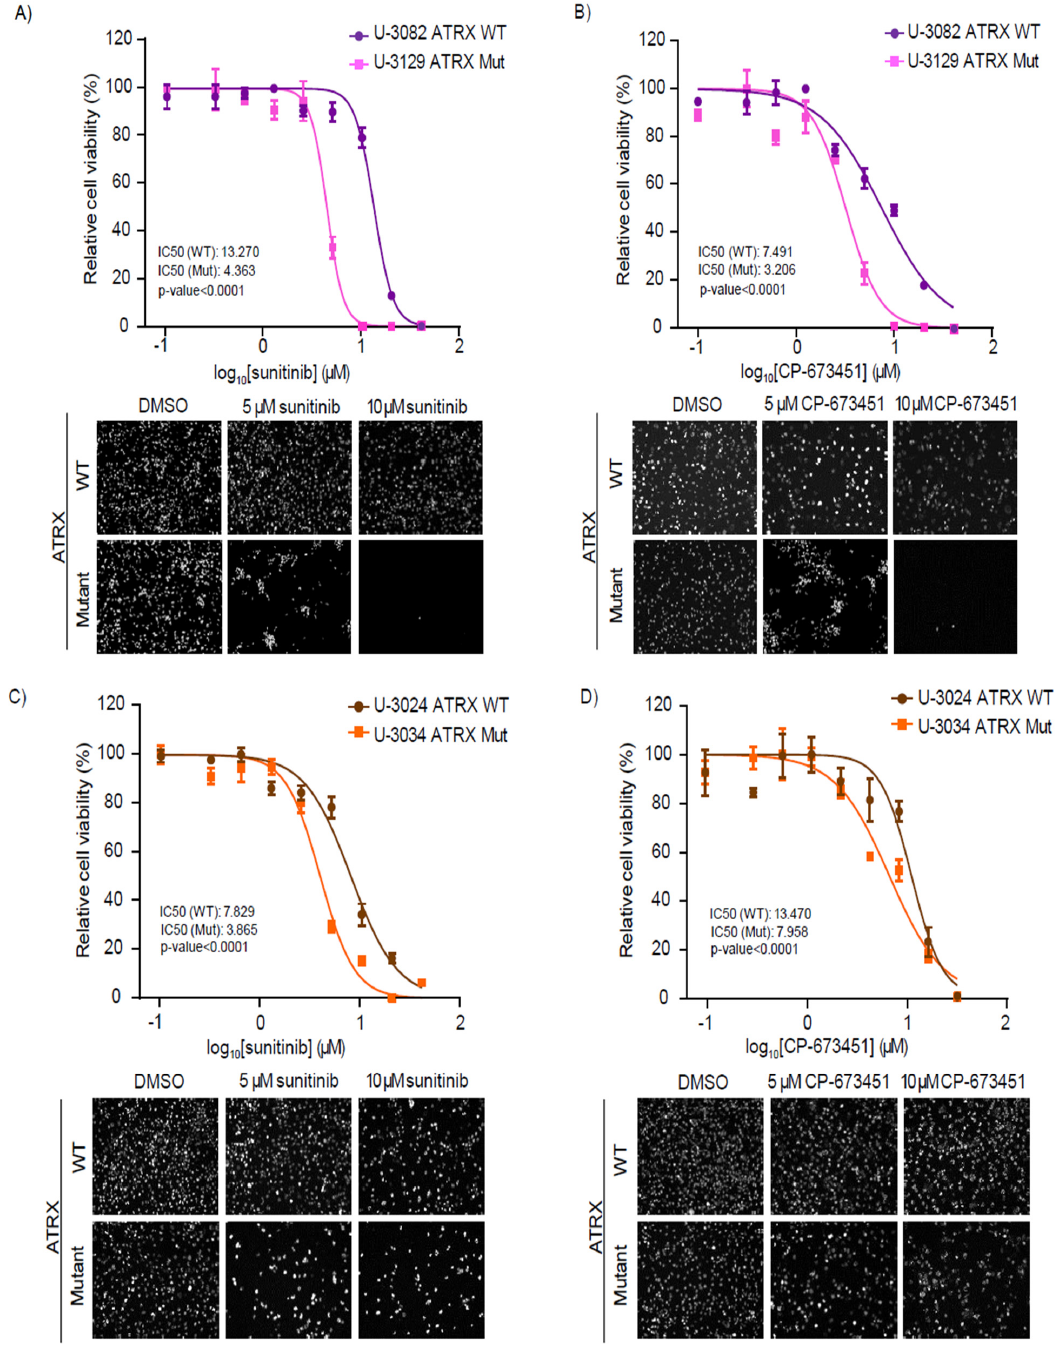
Figure 5. ATRX -mutant patient-derived high-grade glioma cells are sensitive to RTK and PDGFR inhibitors. ( A – D ) Relative cell viability of ATRX WT (U-3082 and U-3024) and ATRX Mutant (U-3129 and U-3034) high-grade glioma cell lines treated with increasing doses of the indicated drug. The IC50 values were calculated from the dose–response curve determined by GraphPad Prism. Data shown correspond to a representative experiment (with technical triplicates) out of three biological replicates. SEMs from each data point are indicated. Significance was assessed using F-test and the p -value for each dataset is shown. Representative images of ATRX WT and ATRX Mutant cells after 48h of treatment with DMSO or the indicated drug concentrations are